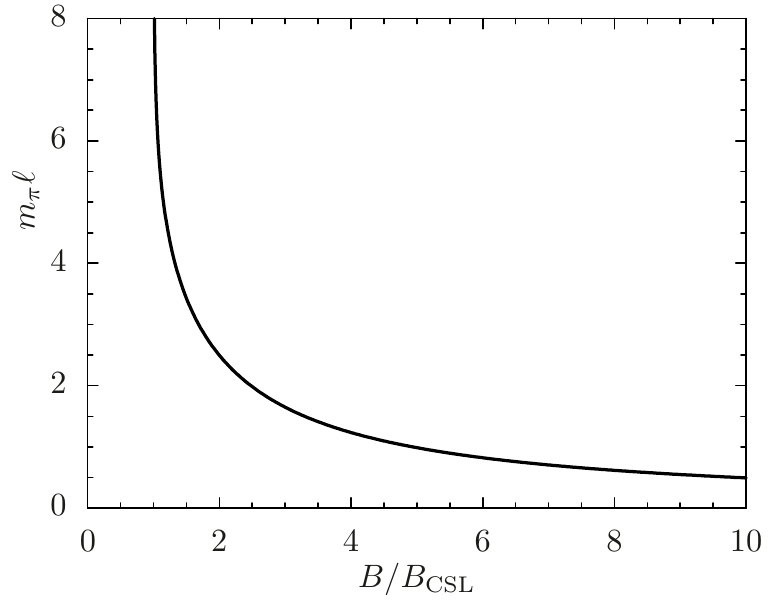
Figure 3 . The period of the CSL ‘ in units of inverse pion mass as a function of magnetic (cid:12)eld. where m N is the nucleon mass. To see this, just combine eqs. (4.2) and (4.5) to write